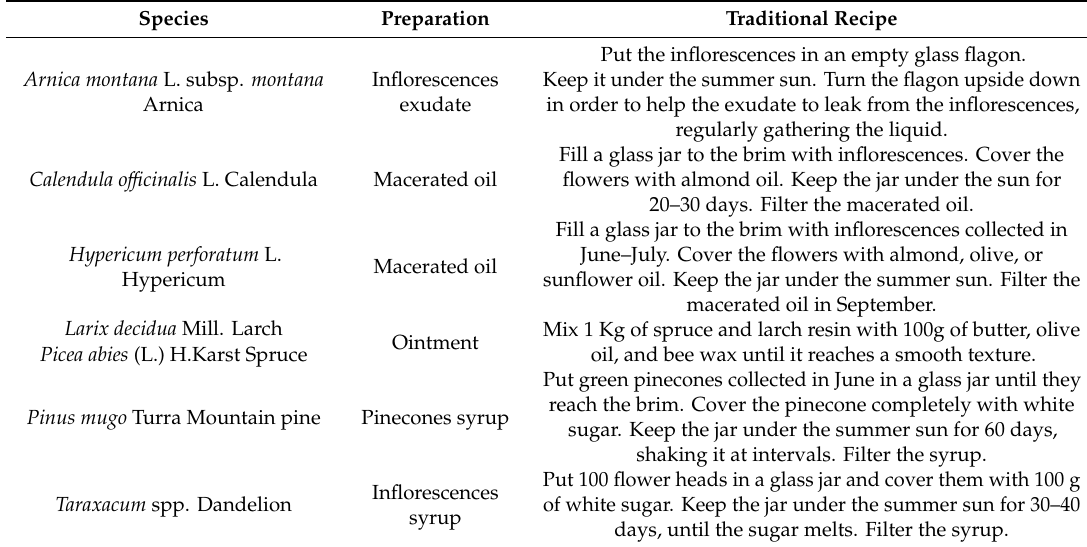
Table 1. Some of the traditional preparations in the village of Caspoggio. Species Preparation Traditional